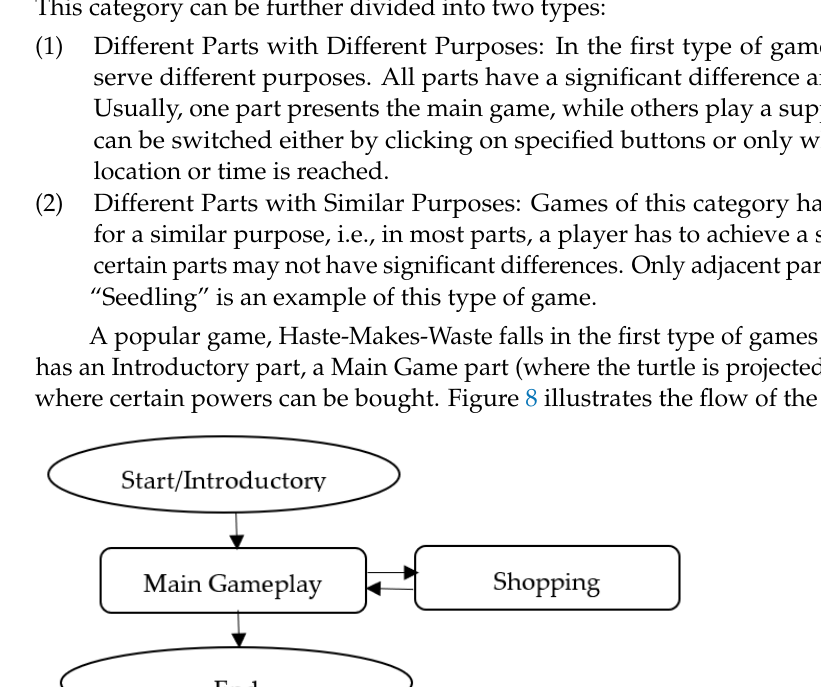
Figure 7. Similar levels of the Color Bridge game.